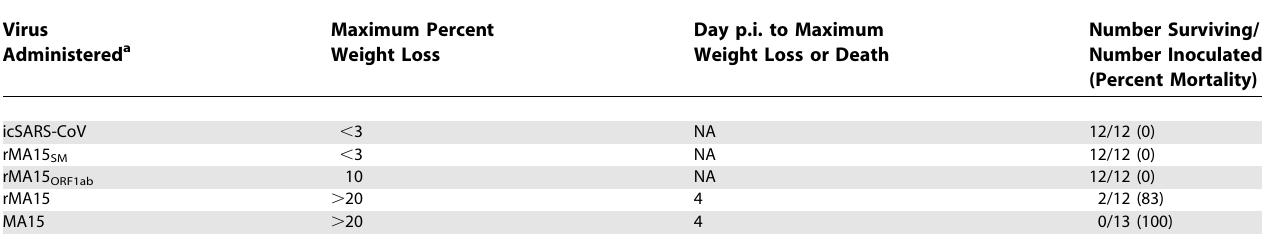
Table 2. Morbidity and Mortality in Mice following Intranasal Administration of MA15 and Recombinant Viruses Virus Administered a